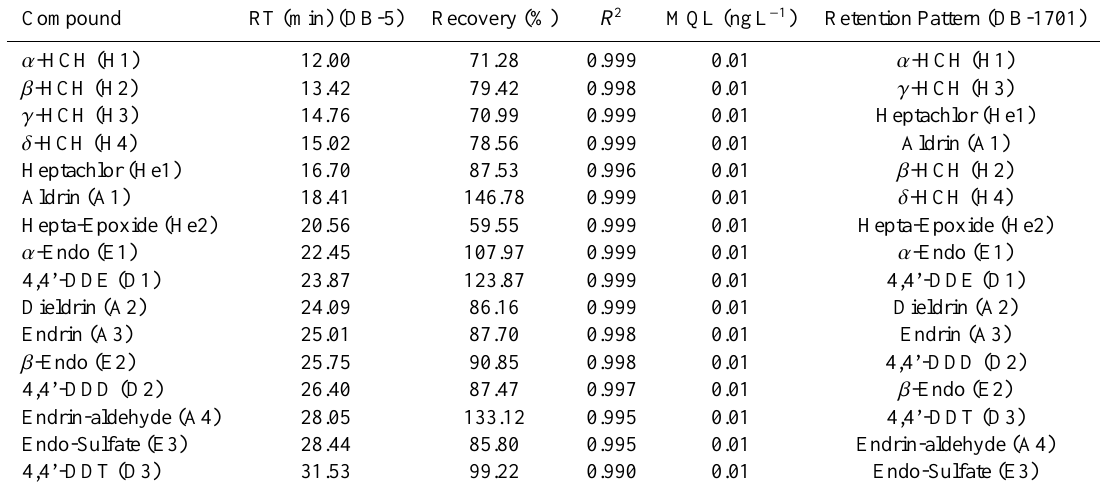
Table 3. Standardisation of OCP’s compounds using GC-ECD. Compound